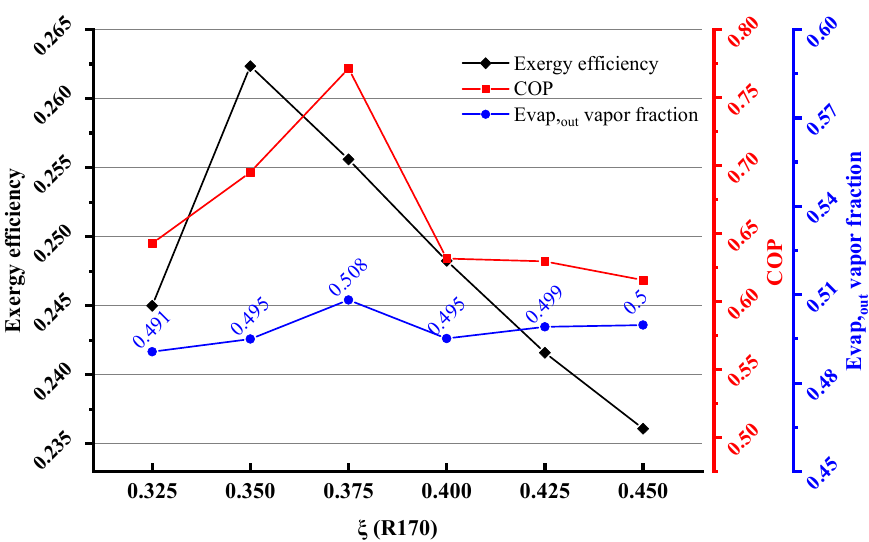
Figure 6. The coefficient of performance, exergy efficiency, and outlet vapor fraction of evaporator at different concentrations. different concentrations.